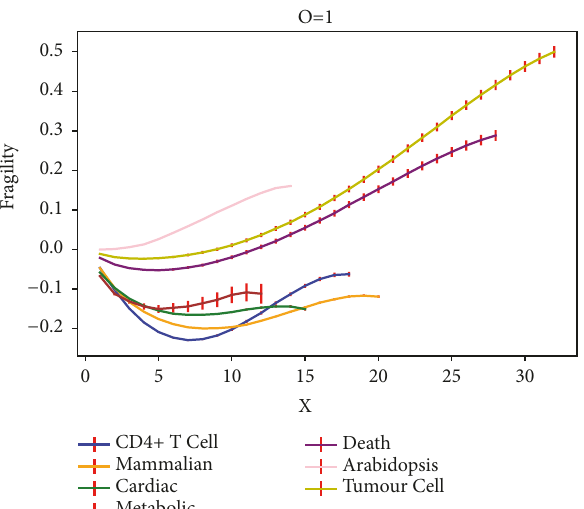
Figure 5: ∮ of biological Boolean networks. The error bars represent the standard error of measurements for 1000 different initial states run by 200 steps.